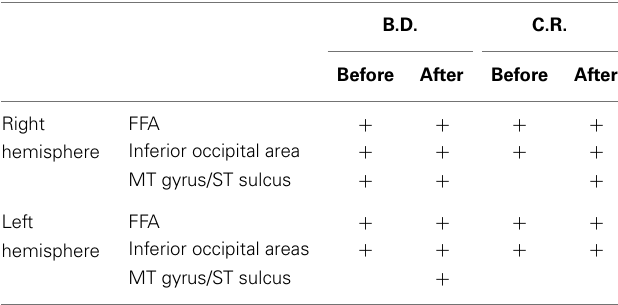
Table 1 | Main activated regions for faces before and after lobectomy in right MTLE patients .